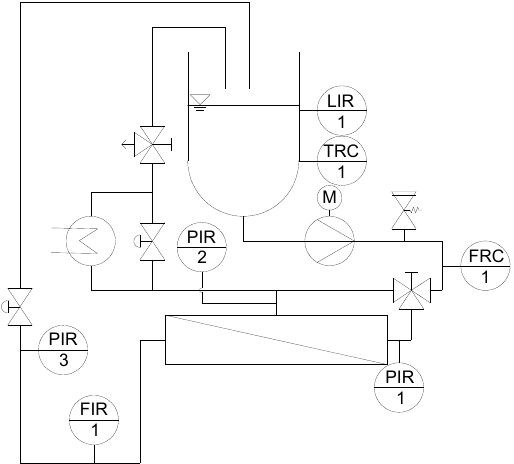
Figure 2. P&I diagram of the pilot scale plant for SWM (LIR: Level indicator recorder; TRC: Temperature recorder controller; PIR: Pressure indicator recorder; FRC: Flow recorder controller; FIR: Flow indicator recorder) [20].